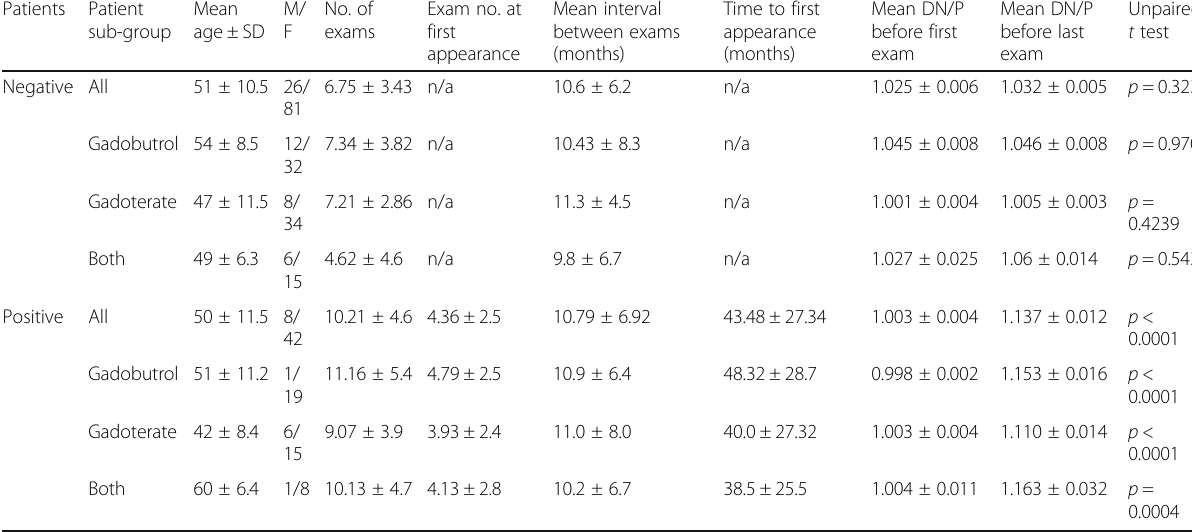
Table 1 Summary of patients with and without visible T1-hyperintensity of the DN and changes in DN/P SI ratio Patients Patient Mean M/ No. of sub-group age ± SD F